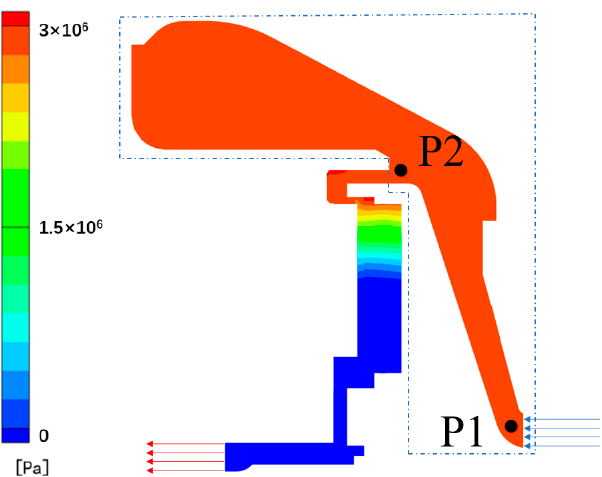
Figure 4. Pressure distribution of the first-stage liquid-sealing impeller.